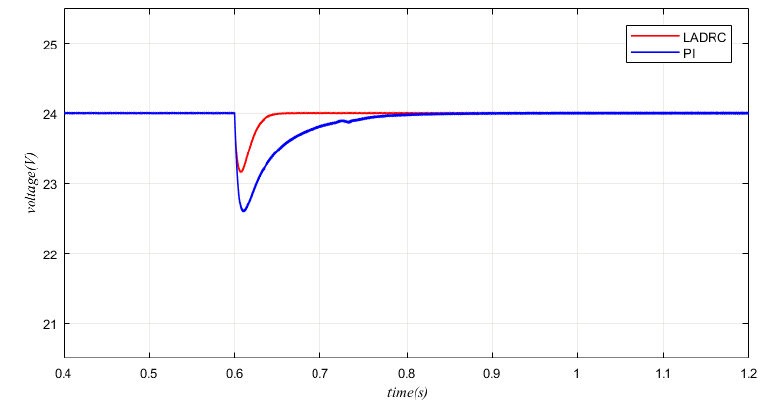
Figure 10. Output voltage responses in Case 2.